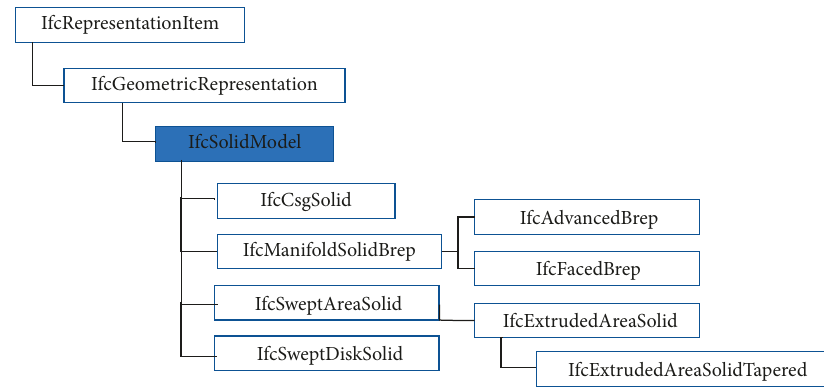
Figure 3: The IFC entity inheritance